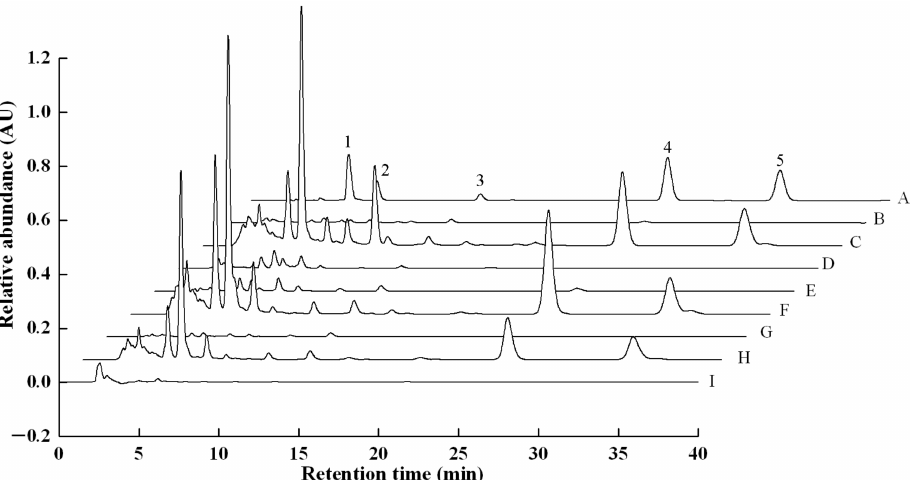
Figure 1. HPLC profiles of reference standards and the extraction of the terpenes of W. cocos (wavelength = 241 nm). 1, dehydrotumulosic acid; 2, polyporenic acid C; 3, pachymic acid; 4,